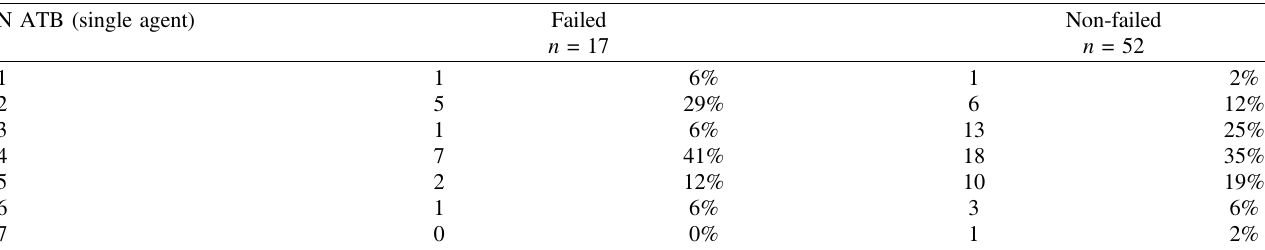
ATB – a single antibiotic.